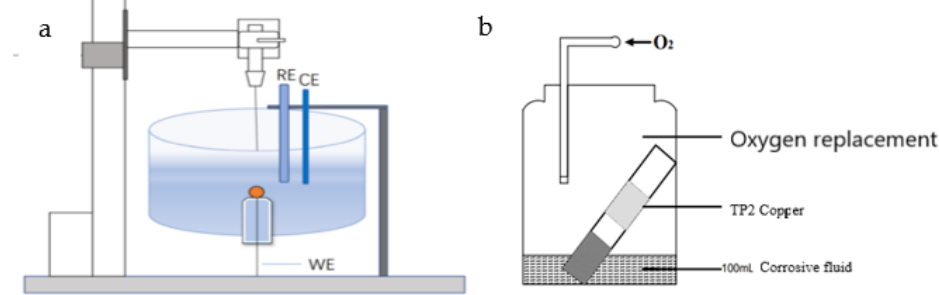
Figure 1. ( a ) SVET test schematic diagram; ( b ) schematic diagram of simulated exposure experi- ment.